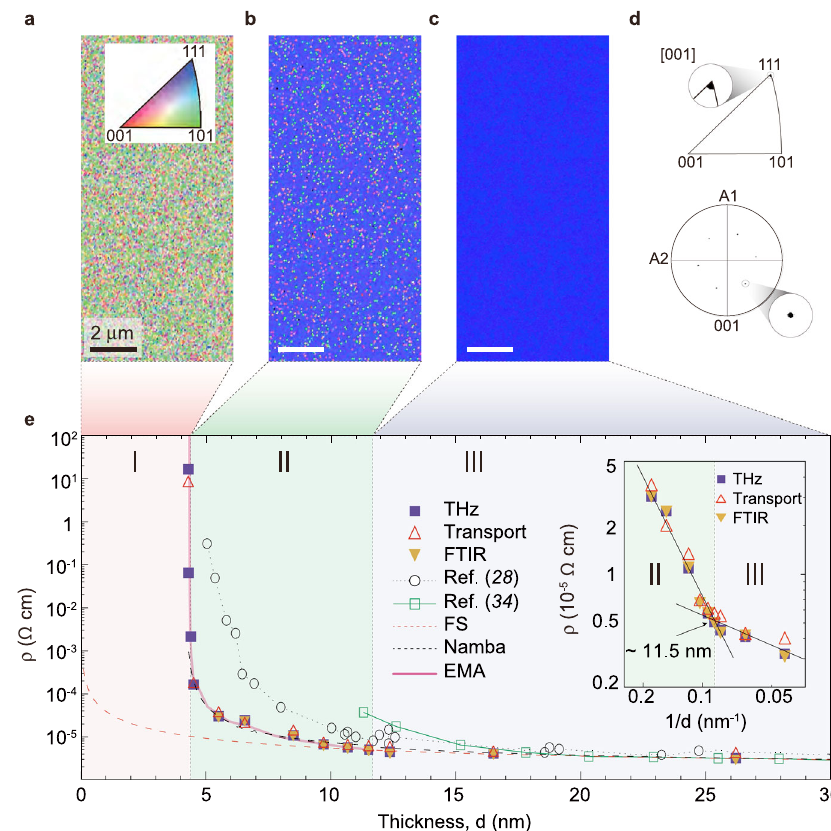
Fig. 6 | Three phases of the initial stages of fi lm growth: nucleation, coherent merging and single-crystal thin fi lm formation. a – c Electron backscatter dif- fractionimagesofCuthin fi lmsin a stageI(Nucleationandislandgrowth), b stageII (Coherent merging) and c stage III (SC fi lm). d IPF with a sole spot associated with the (111) plane (upper panel) and [100] PF demonstrating the six-fold symmetry of the{100}PF(lowerpanel).TheinsetimagesinIPFandPFareenlargedimagesofthe sole-spotareas. e Thickness-dependentresistivity( ρ )ofSC fi lmsaccordingtodirect